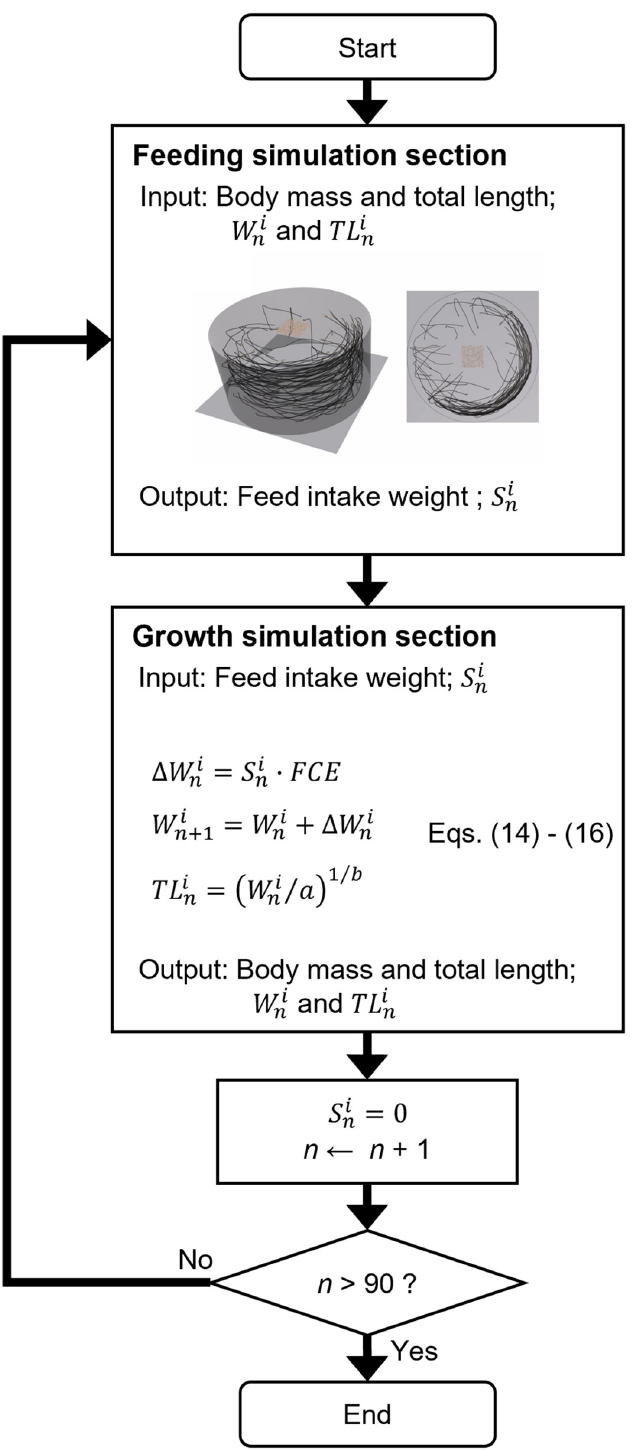
Fig 1. Schematic of the proposed simulation method. The proposed simulation was composed of a “Feeding simulation section” and a “Growth simulation section”. The simulation was repeated until the final day of the experiment (day 90). The details are shown in a flow chart in Fig